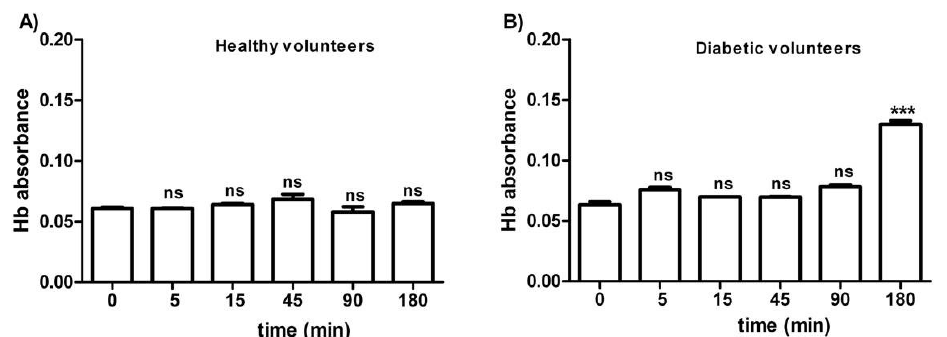
Figure 1. Osmotic fragility measured as hemoglobin (Hb) absorbance (optical density) in erythrocytes from healthy volunteers ( A ) and diabetic volunteers ( B ). ns (not significant) versus different time intervals considered (5–15–45–90 min); *** p < 0.05 versus di ff erent time intervals (0–5–15–45–90 min) as determined by one-way ANOVA followed by Bonferroni’s post-hoc test ( n = 10).